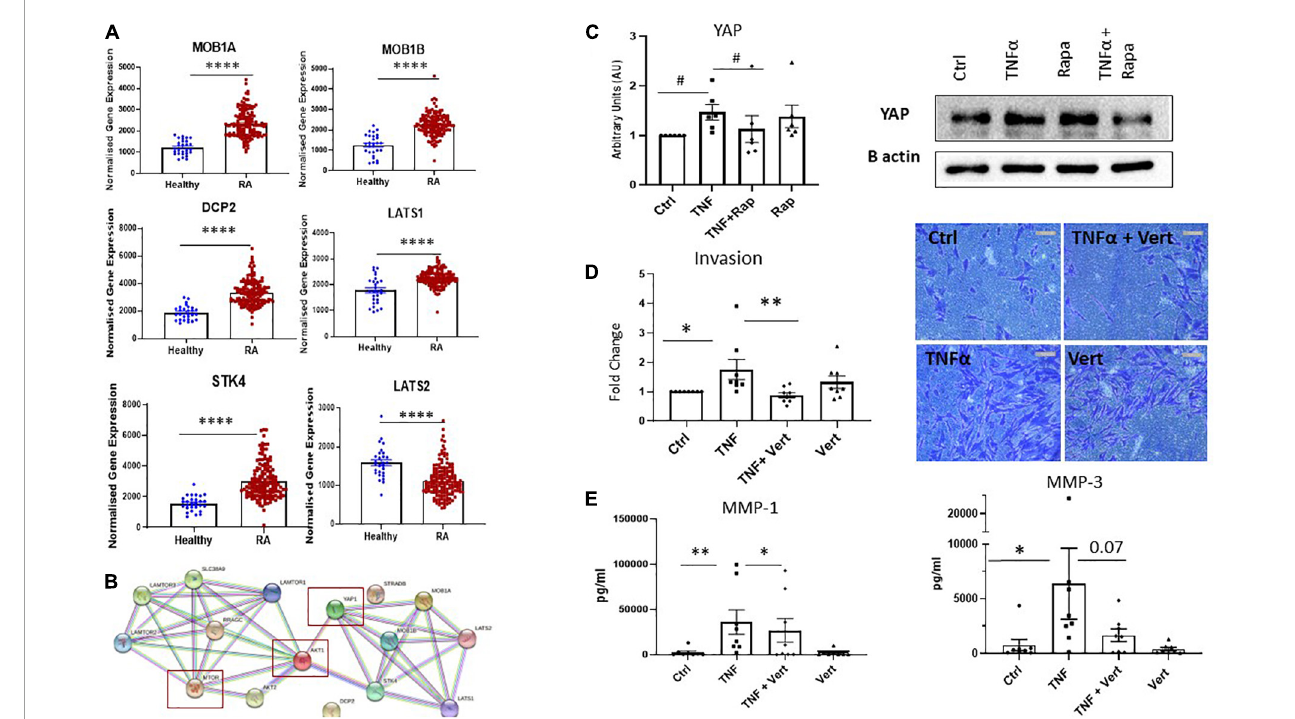
FIGURE5 Crosstalk between dysregulated Hippo-YAP and mTOR pathways mediates RASF invasion. (A) Bar graphs demonstrating normalized gene expression of MOB1A, MOB1B, DCP2, LATS1, STK4, and LATS2 in RA patients ( n = 152) compared to healthy donors ( n = 28). (B) Predicted interactions of dysregulated YAP associated genes with dysregulated genes within mTOR pathway using STRING pathway analysis. (C) Representative western blot images and bar graph showing total YAP expression in RASF ( n = 6) treated with TNF α (1 ng/ml) and Rapamycin (100 nM) alone or in combination for 24 h, B-actin was used as a loading control. (D) Representative photomicrographs and accompanying bar graph demonstrating invasion and average number of invading cells in RASF ( n = 8) treated with TNF α (1 ng/ml) and Verteporfin (50 nM) alone or in combination for 48 h. (E) Bar graphs showing measured secretion of MMP-1 and MMP-3 from RASF ( n = 8) treated with TNF α (1 ng/ml) and Verteporfin (50 nM) alone or in combination for 24 h. Values in graphs expressed as mean ± SEM. Non-parametric unpaired Mann–Whitney t -test used for comparisons between healthy donors and RA patients. Friedman Test with Dunn’s multiple comparison and Wilcoxon signed rank test were utilized for RASF. ∗ p < 0.05, ∗∗ p < 0.01, ∗∗∗∗ p < 0.0001, and # p < 0.05